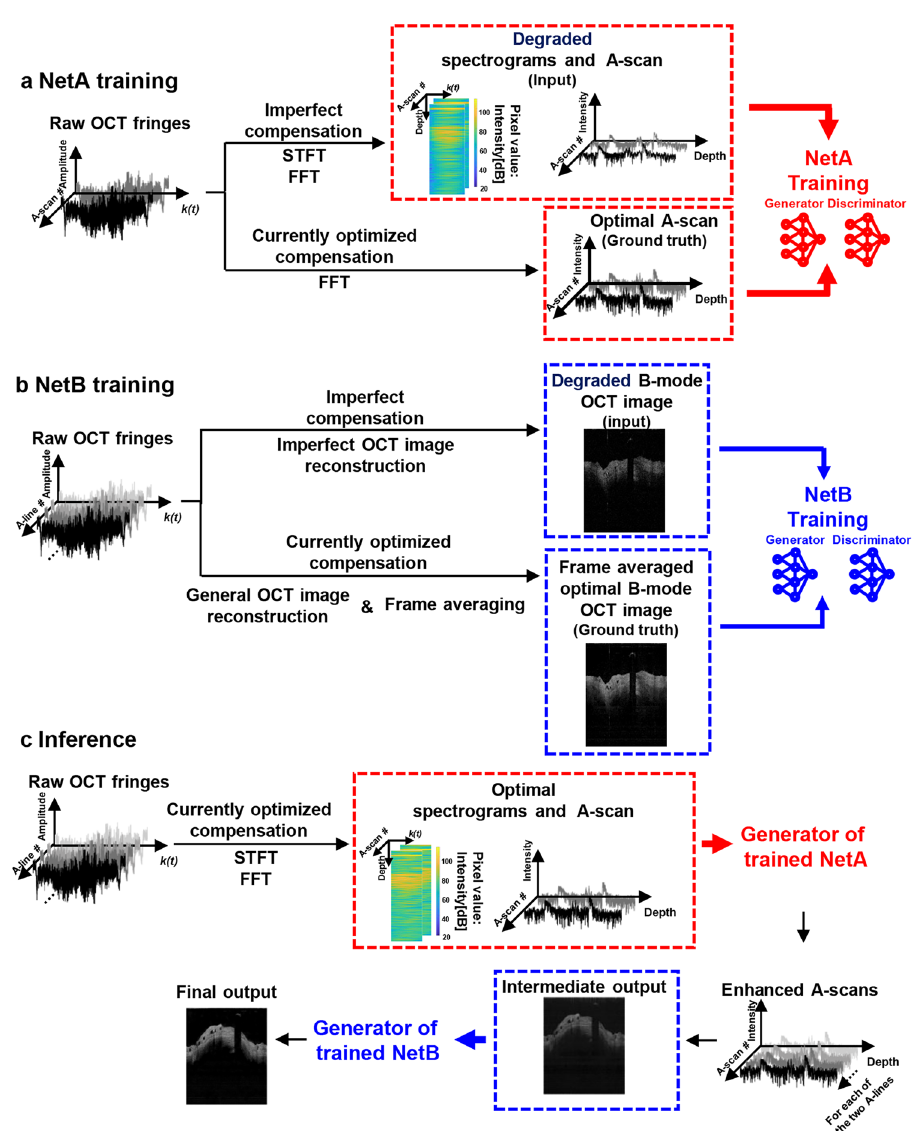
Fig. 1 Schematic of deep learning-based OCT image enhancement framework. a Training phase of NetA. Based on A-scans, NetA takes two adjacent interference fringes and uses them as input after transforming them into spectrograms and typical OCT A-scans. b Training phase of NetB. NetB is implemented based on OCT B-scans consisting of 1024 A-scans. In both networks, the ground truth was constructed utilizing the best currently available data through numerical post-processing. In NetB, the average of 7 adjacent B-scans was used as the ground truth. Inputs were intentionally degraded spectrograms, A-scans, and B-scans that have been processed with degradations such as imperfect dispersion compensation, bandwidth truncation, and SNR deterioration. c Inference phase of proposed OCT image enhancement framework. Data are processed using only the generators of the two trained networks. Note that currently optimized interference fringes are used as input to further enhance state-of-the-art OCT images. NetA processes A-scans sequentially for one frame and NetB processes results of Net A to produce fi nal